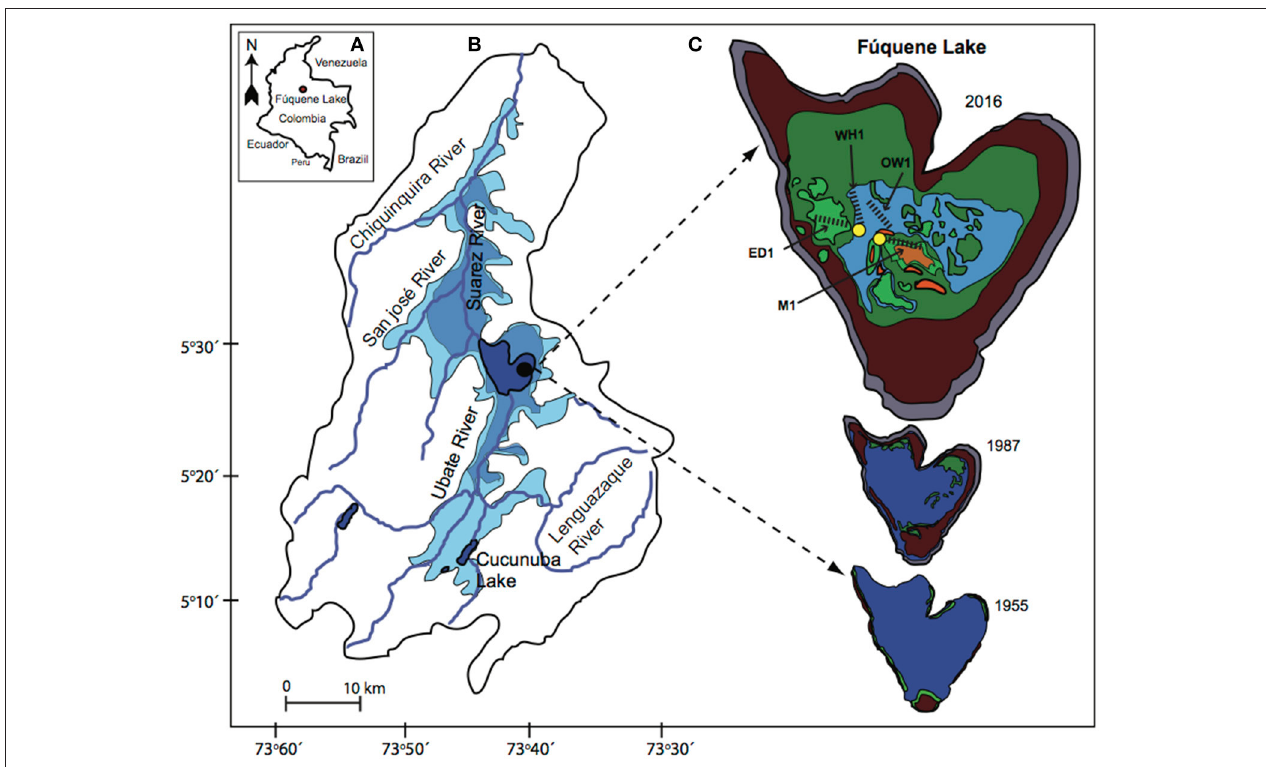
FIGURE 1 | (A) Map showing the geographical location of Fúquene Lake in Colombia, South America; (B) the drainage catchment showing present-day lake surface area (dark blue) and historical lake surface area extensions revealed by lake sediments during the Pleistocene (light blue; modified after Bogotá-A et al., 2011) and by a hydrological map from 1936 (pale blue; modified after Franco et al., 2011); (C) map of Fúquene Lake showing a representation of macrophyte cover at 1955, 1987 and present-day as revealed by aerial photography (Bustamante Sanint, 2010) and satellite images (Google Inc.). Blue, open waters; dark green, Eichhornia crassipes cover; light green, Egeria densa cover; red, Azolla filiculoides cover; brown, reed fringe; gray, surrounding canal. Four contemporary sampling transects selected according to macrophyte dominant type are indicated (dash black lines) in the present-day lake map. WH1, E. crassipes ; ED1, E. densa ; M1, mixed assemblage of macrophyte species; and (iv) OW1, open waters. Coring locations of LFUQ-M1 core (M1 transect) and LFUQ-B1core (WH1 transect) are indicated in yellow